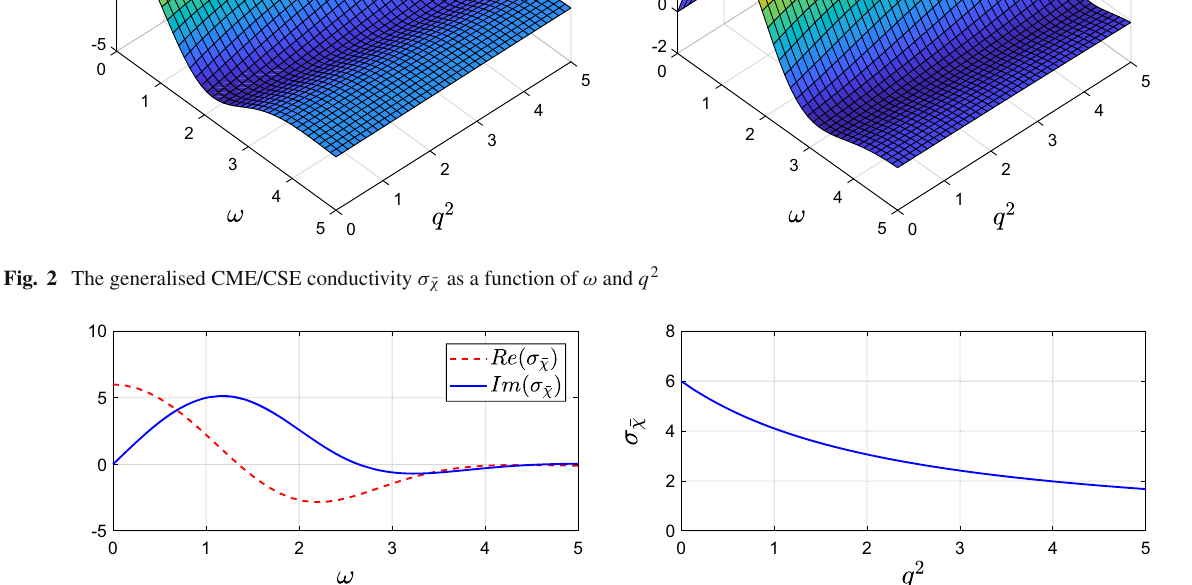
Fig. 3 ω -dependence of σ ¯ χ when q = 0 (left); q 2 -dependence of σ ¯ χ when ω = 0